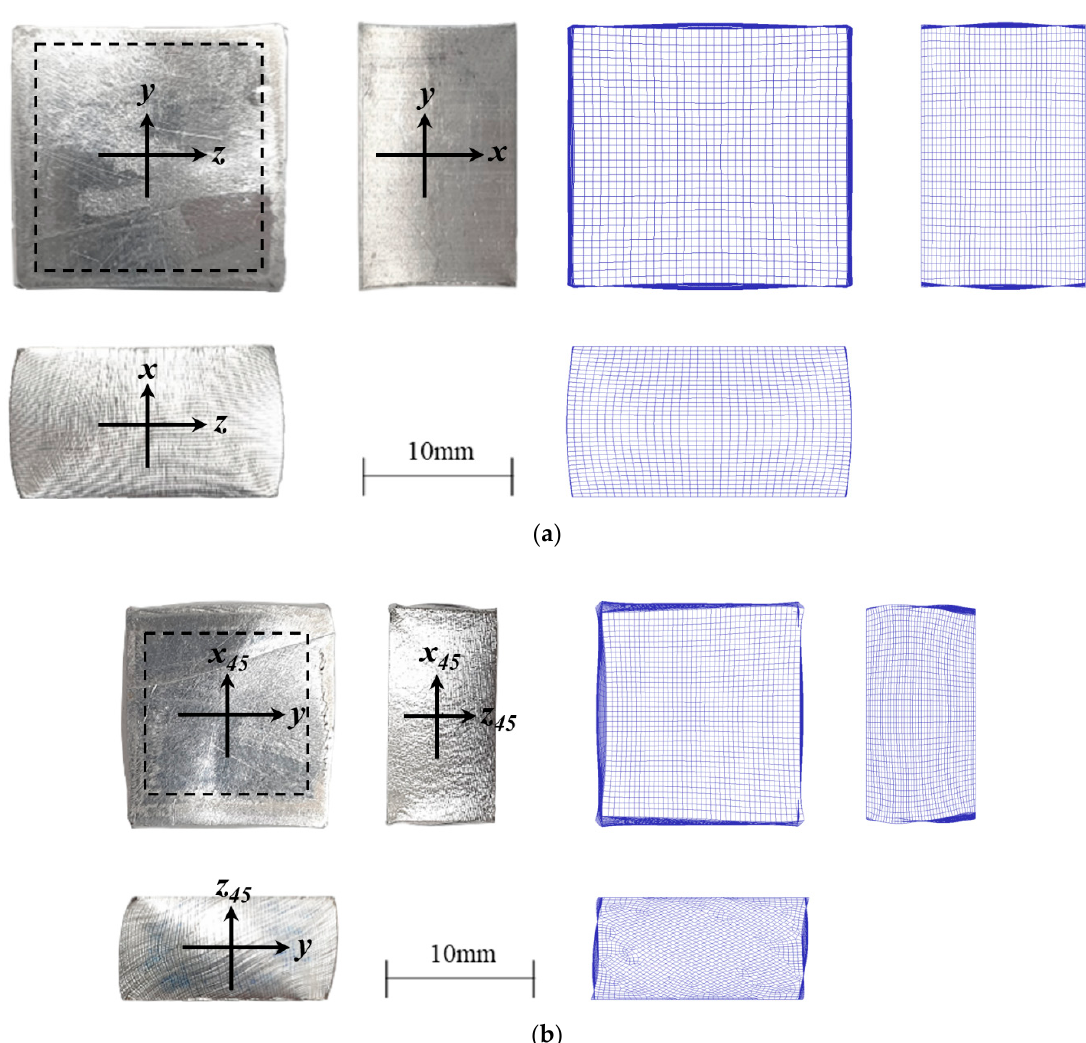
Figure 12. Comparison of deformed shapes between experimental results and FE analysis: ( a ) Z 0 , ( b ) Y 45